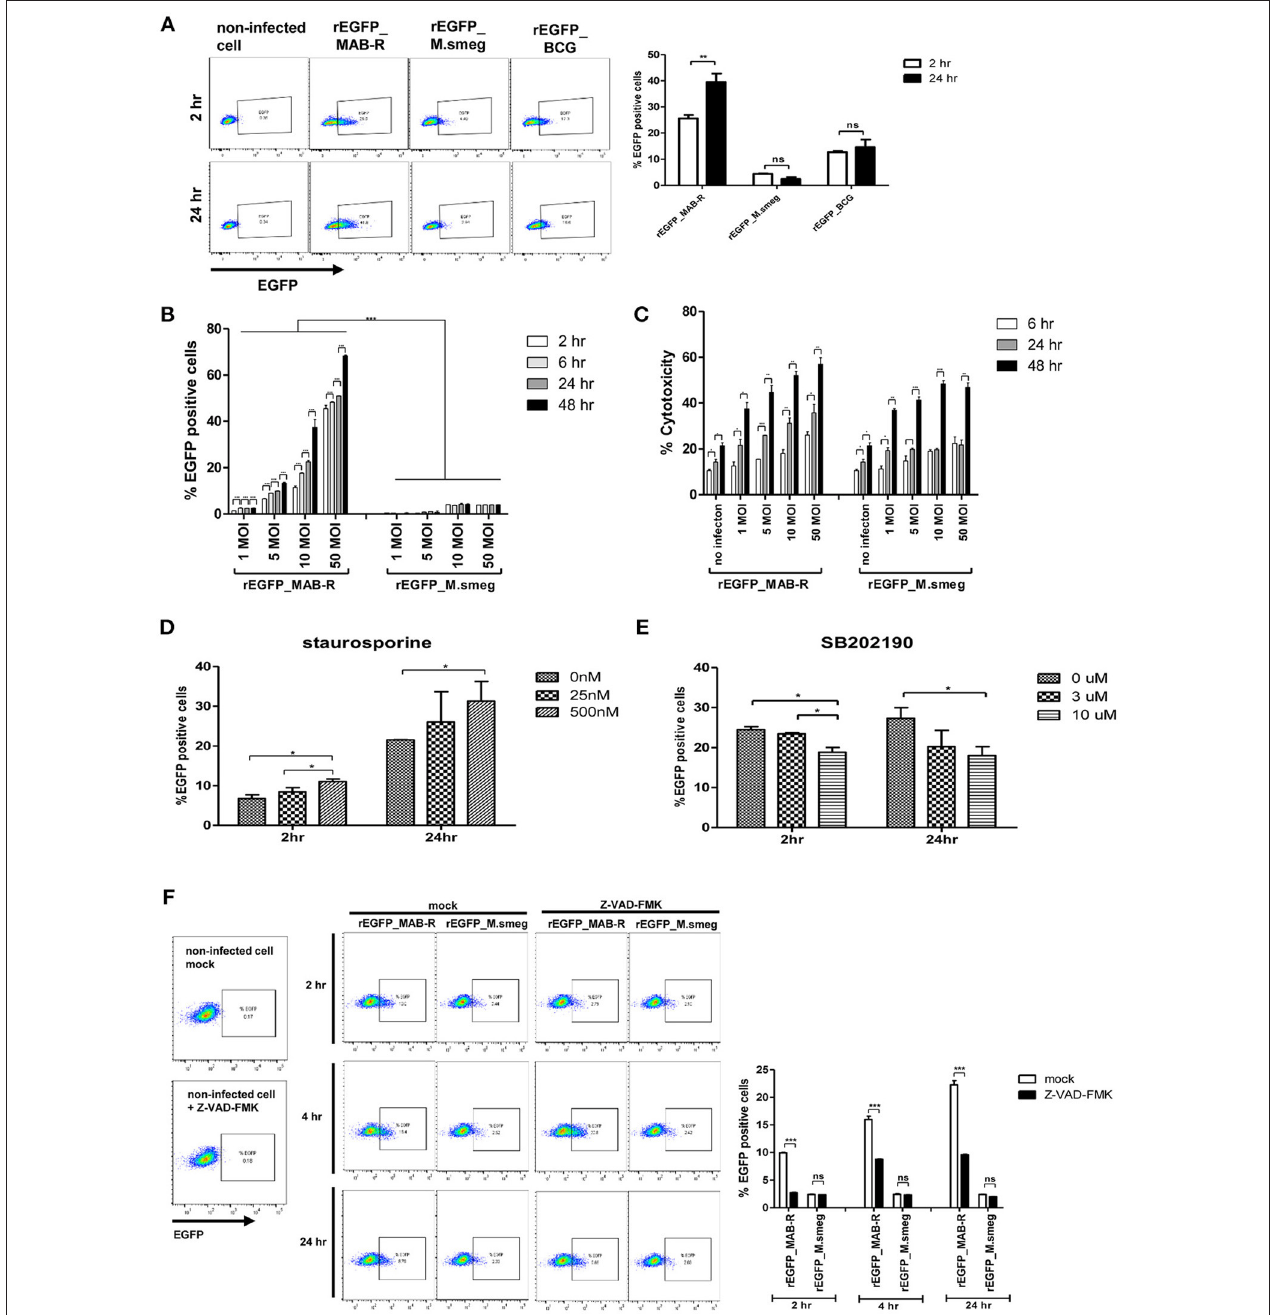
FIGURE 6 | Enhanced apoptotic cell death by a MAB-R strain contributes to its cell-to-cell spread. (A) BMDMs infected with EGFP-expressing bacteria [EGFP recombinants: rEGFP_MAB-R (Asan 50594), rEGFP_M.smeg ( M. smegmatis ), rEGFP_BCG ( M. bovis BCG )] for 0 and 24h. EGFP-positive cells were analyzed by flow cytometry. (B,C) J774A.1 cells were infected with rEGFP_MAB-R (Asan 50594) and rEGFP_M.smeg ( M. smegmatis ), and analysis was performed on data at different time points (2, 6, 24, and 48h) or M.O.I.s (1, 5, 10, and 50). (B) The percentage of EGFP-positive cells was evaluated by flow cytometry (FACScalibur). (C) Cytotoxicity was quantitated by measurement of LDH activity in the infected cell supernatants. (D,E) J774A.1 cells were pretreated with staurosporine (apoptosis inducer) or SB202190 (p38 MAPK inhibitor) and infected with MAB-R [rEGFP_MAB-R (Asan 50594)] (10M.O.I.), and the percentage of EGFP-positive cells was measured by flow cytometry (FACScalibur). (F) J774A.1 cells were pre-treated with 10 uM Z-VAD-FMK (pan-caspase inhibitor) for 2 to 24 hr and infected with rEGFP_MAB-R and rEGFP_M.smeg (10M.O.I) for and the percentage of EGFP-positive cells was measured by flow cytometry (FACScalibur). The results are representative of two independent experiments and represent means ± SD. P -values were determined by the Student’s t -test using GraphPad prism program: ns, non-significant; * P < 0.05; ** P < 0.01, and *** P < 0.001.